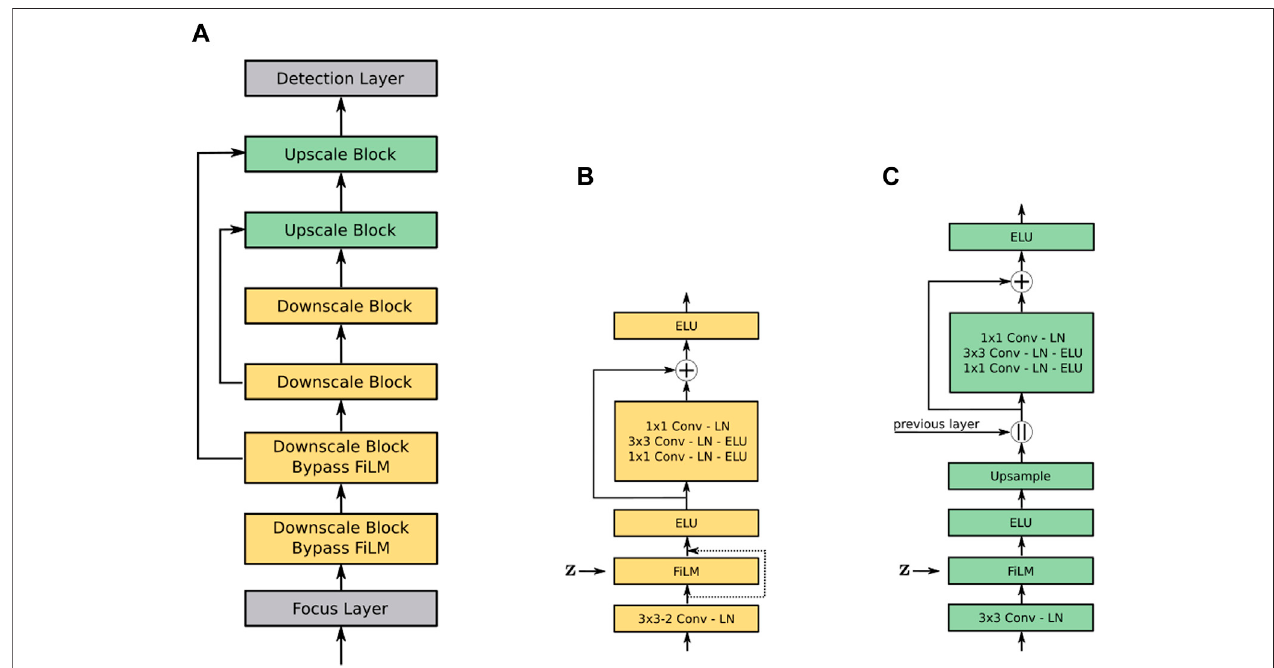
FIGURE 4 | Conditional YOLO architecture (A) and its building blocks (B, C) . The Downscale block (B) applies a 3 × 3 convolution with a stride of 2, halving the spatial dimension of the input feature maps. The FiLM layer is optional and bypassed in the fi rst two Downscale blocks, i.e.,the output of the convolutional layer after normalization is directly fed to the subsequent activation function. In the Upscale block, nearest neighbour up-sampling is applied by a factor of 2 and the feature maps from a given previous layer are concatenated channel-wise. The residual connection in both blocks serves as a bottleneck, reducing the number of parameters as the 3 × 3 convolution is performed with only half the number of output channels, e.g.,64 × 1 × 1, 64 × 3 × 3 and 128 × 1 ×